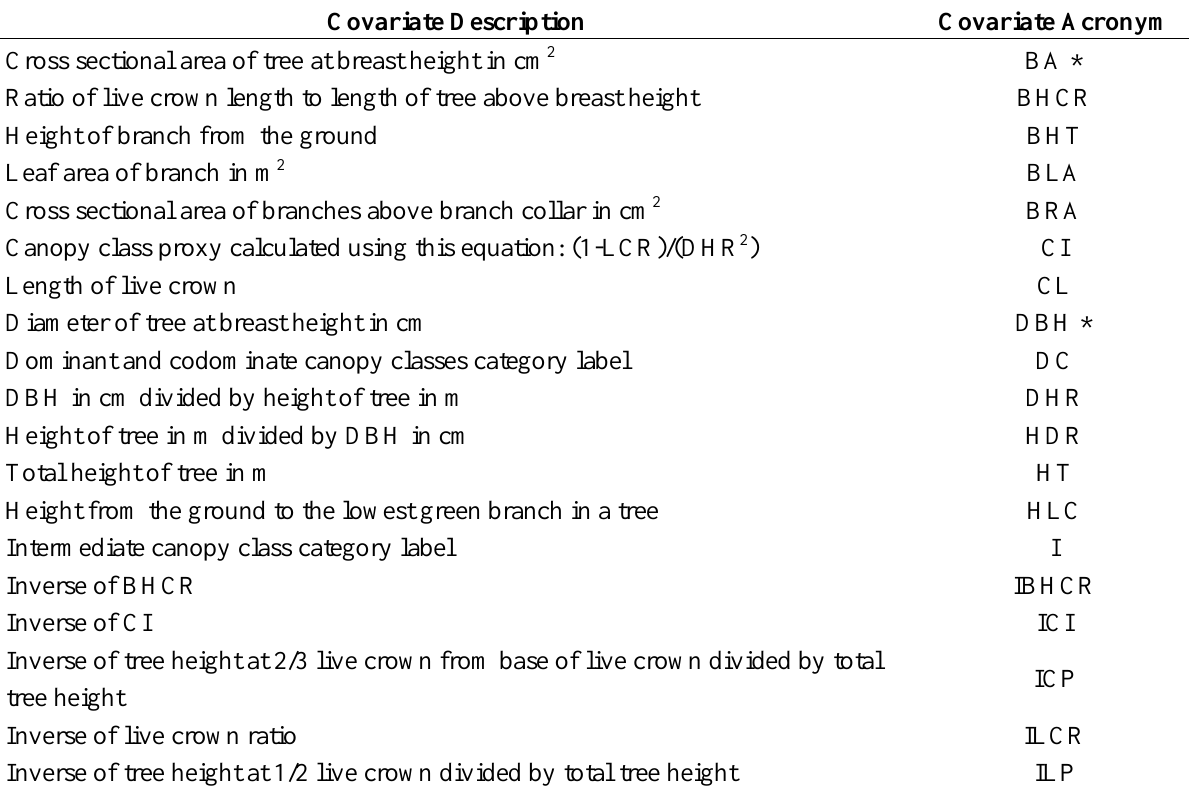
Table 4. List of covariates tested in NLME (nonlinear mixed effects)